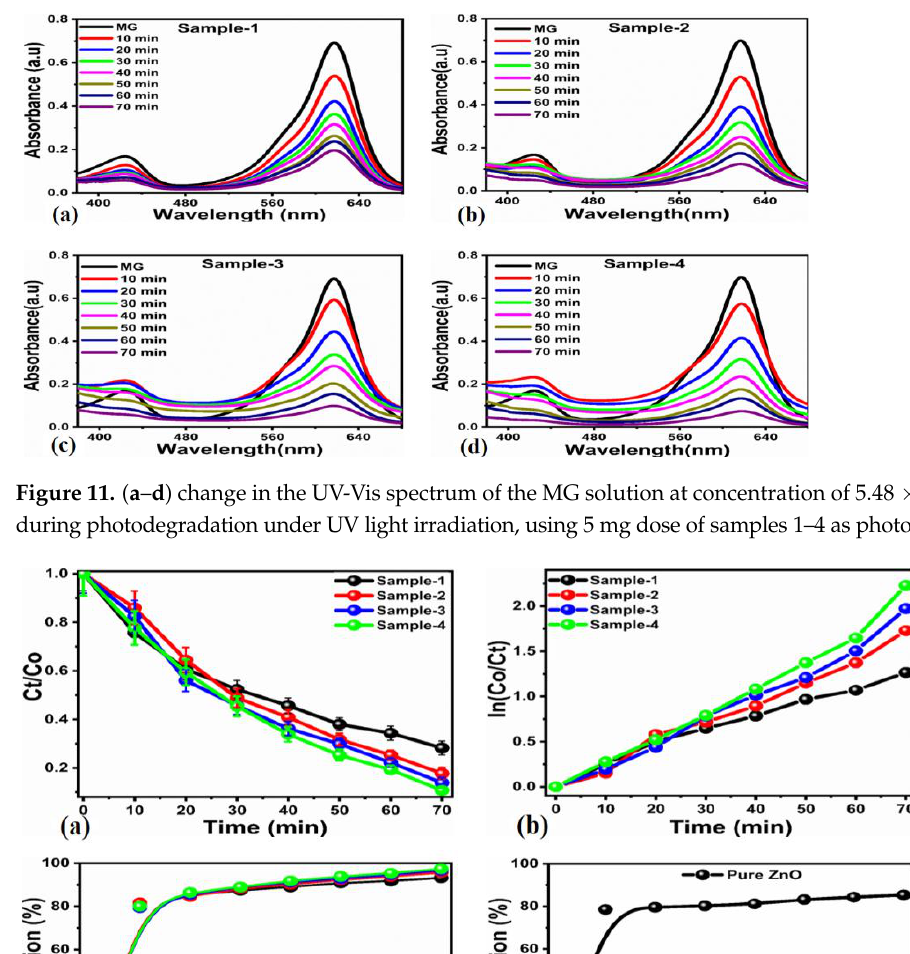
12 of 17 Figure 10. Degradation over time (140 min) of a solution of MG of concentration 5.48 × 10 −5 M under irradiation with UV light in the presence of 5 mg of pristine ZnO. ( a ) Time change of the UV-vis spectrum, ( b ) kinetics C t / C o irradiation time, ( c ) Ln C t / C o plot of pure ZnO over MG. In this way, the hybrid materials Mn 3 O 4 @ZnO were also tested, with their absorption spectra over time shown in Figure 11. All materials functionalized with Mn 3 O 4 proved to be highly efficient for the degradation of MG, as can be seen from the strong decrease of the absorption peak at 617 nm. Note that the degradation experiment in this case only lasted 70 min. Comparing the four panels (a – d), it can be seen that a greater quantity of Mn 3 O 4 increases degradation efficiency. The excellent performance of the hybrid materials can therefore be reasonably attributed to the functionalization with Mn 3 O 4 , which acts as